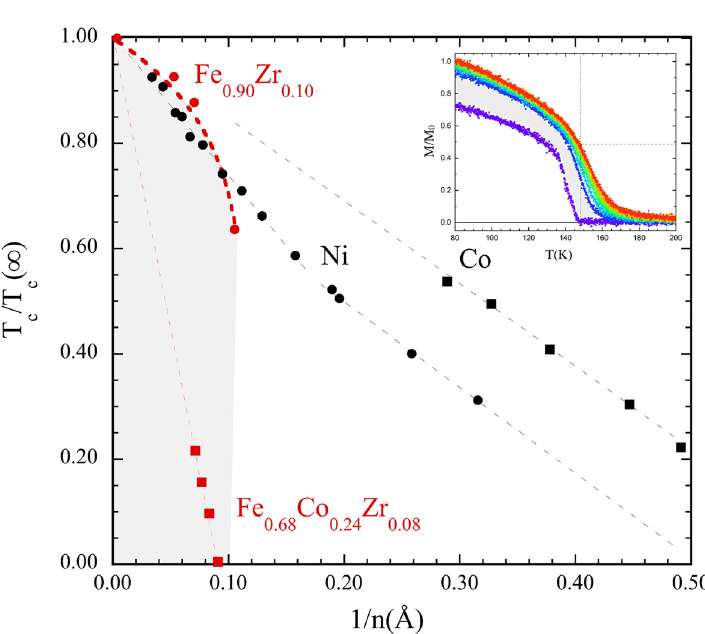
Fig. 5. Illustration of the changes in T c (n)/T C ( ∞ ) with inverse thickness of crystalline and amorphous layers. The Ni and Co data are adapted from Huang et al. 29 , the FeCoZr from Ahlberg et al. 30 and Fe 0.90 Zr 0.10 from reference Korelis et al. 31 . The inset illustrates the the temperature and field dependence of the magnetisation in a 1.5 nm Fe 0.89 Zr 0.11 at fields between 0 and 6 mT adapted from Liebig et al. 32